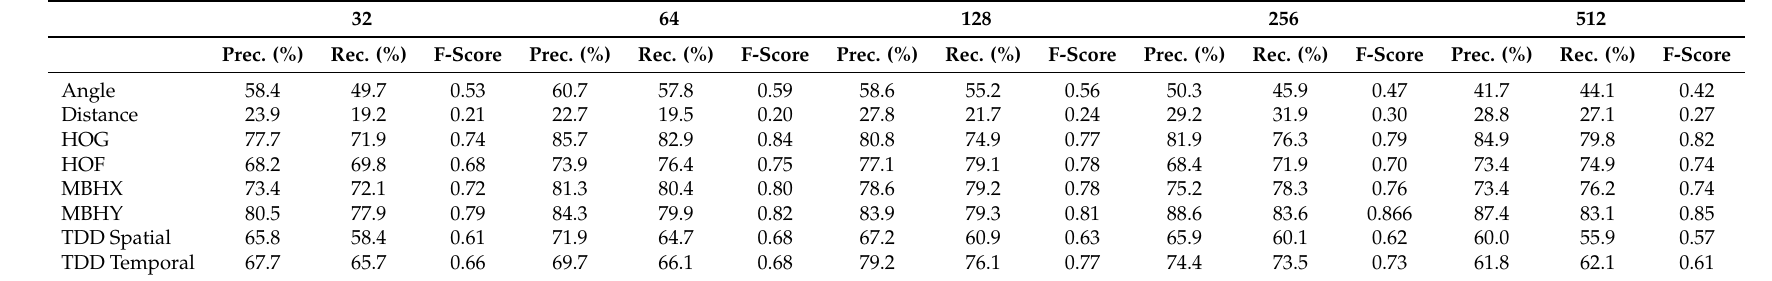
Table 2. Results regarding the unsupervised framework with different feature types on CHU